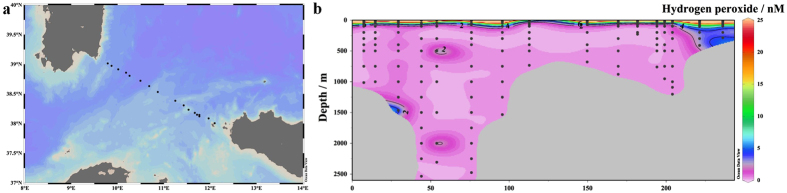
(a) Ocean Certain western Mediterranean transect between Sardinia and Sicily, August 2015 (b) H2O2 concentrations along the transect plotted as distance along section shown (km) from northwest (left) to southeast (right). Plotted in Ocean Data View54.